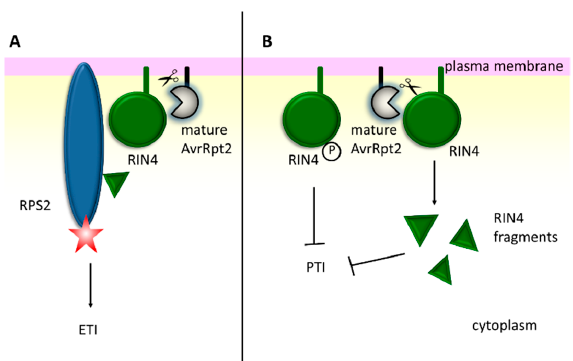
Figure 5. The AvrRpt2 effector protease from P. syringae suppresses the PTI plant response, but may induce the ETI signaling. One of the AvrRpt2 targets is a membrane protein RIN4 (RPM1-interacting protein 4). ( A ) In the resistant plant, cleavage of RIN4 is sensed by the RPS2 protein, whose activation triggers the ETI pathway [105]. ( B ) In the sensitive plant lacking RPS2, the degradation of RIN4 by AvrRpt2, or its phosphorylation by other bacterial effectors, generates products that efficiently inhibit PTI signaling [142,143]. Star, arrow and T-bar stand for activated RPS2 protein, stimulation and inhibition, respectively.